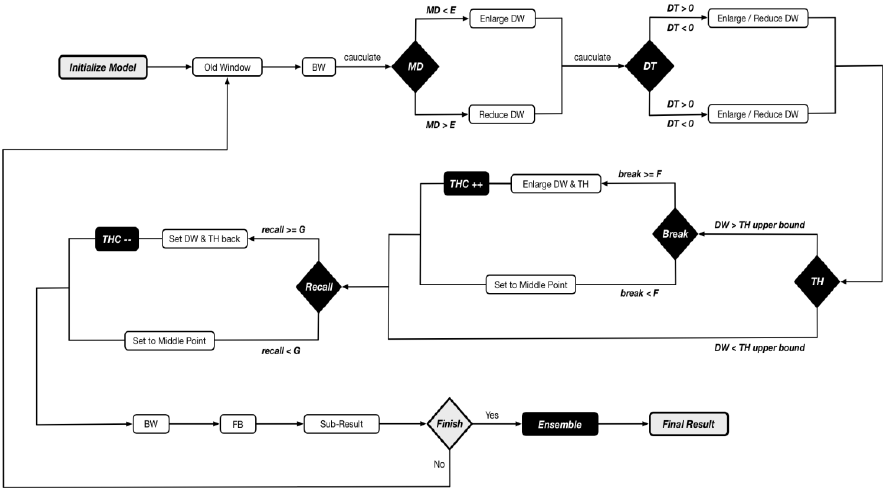
Figure 7. Workflow of AA-HMM.